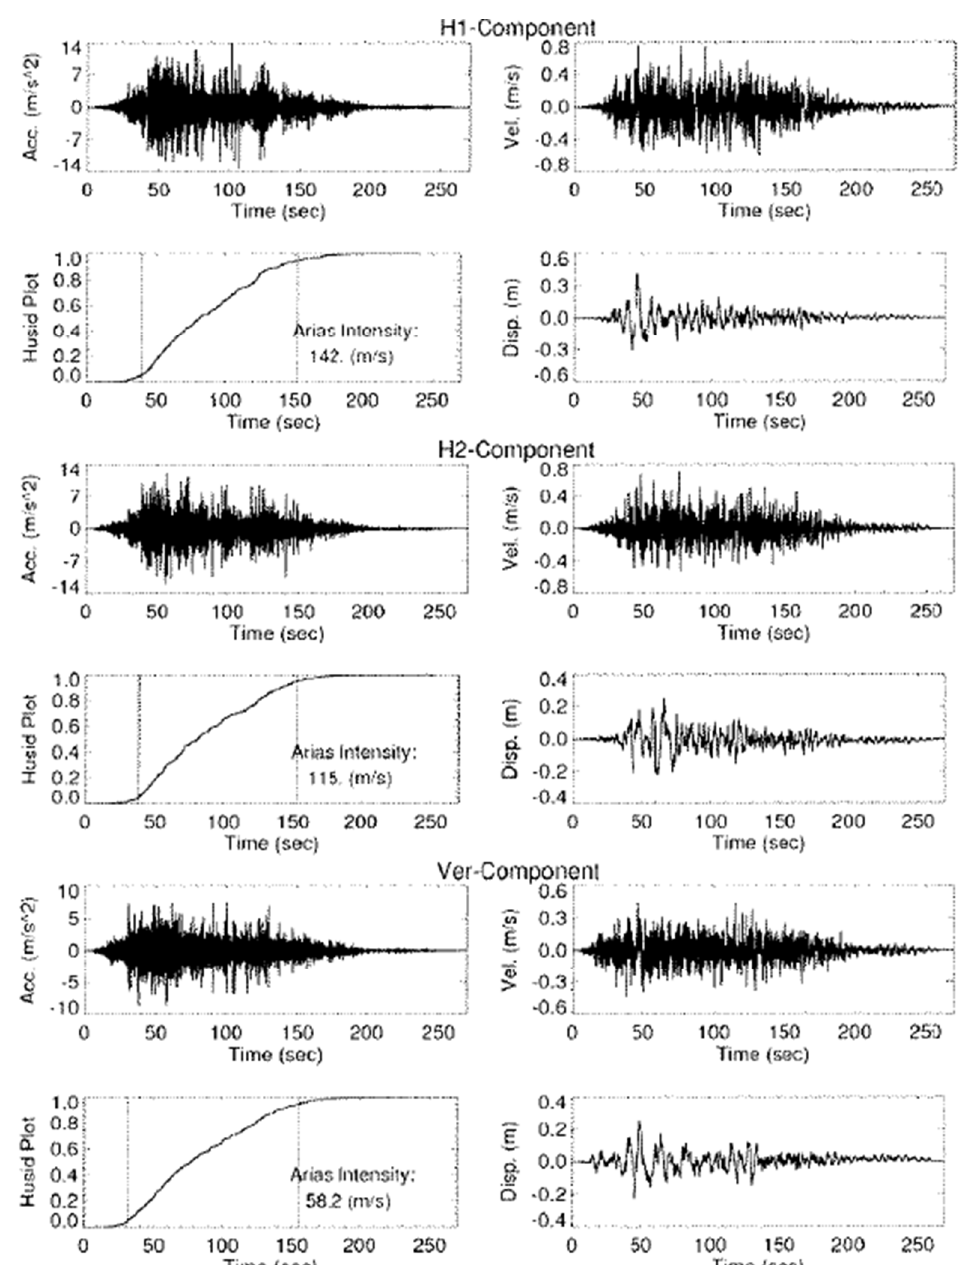
Figure A1. Example SRCH10-SP seeded and spectrum matched 10k-year ground motions, and Husid Plot considered during Feasibility Design Structural Analyses. Vertical lines on Husid Plot represent the time required to build from 5% to 95% of the Arias intensity [44]. The H1 component considered representative of upstream-downstream loading, and H2 as representative of cross-canon loading.